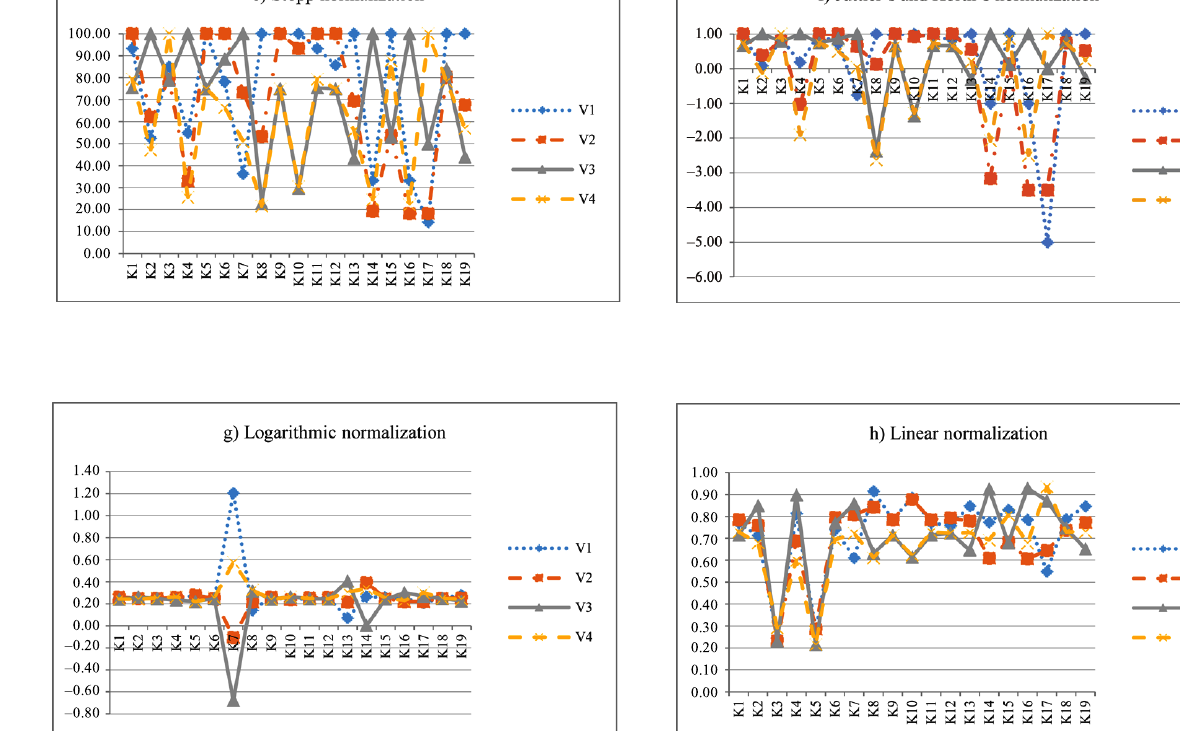
Fig. 2 (a–h). Criteria normalization according to the analysed